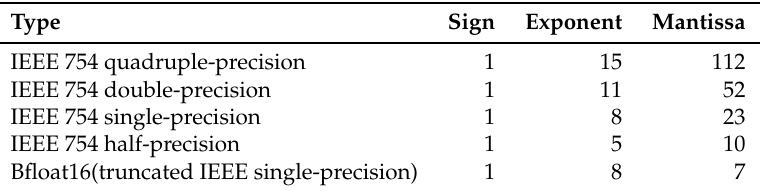
Table 1. Bitwidth of common floating-point